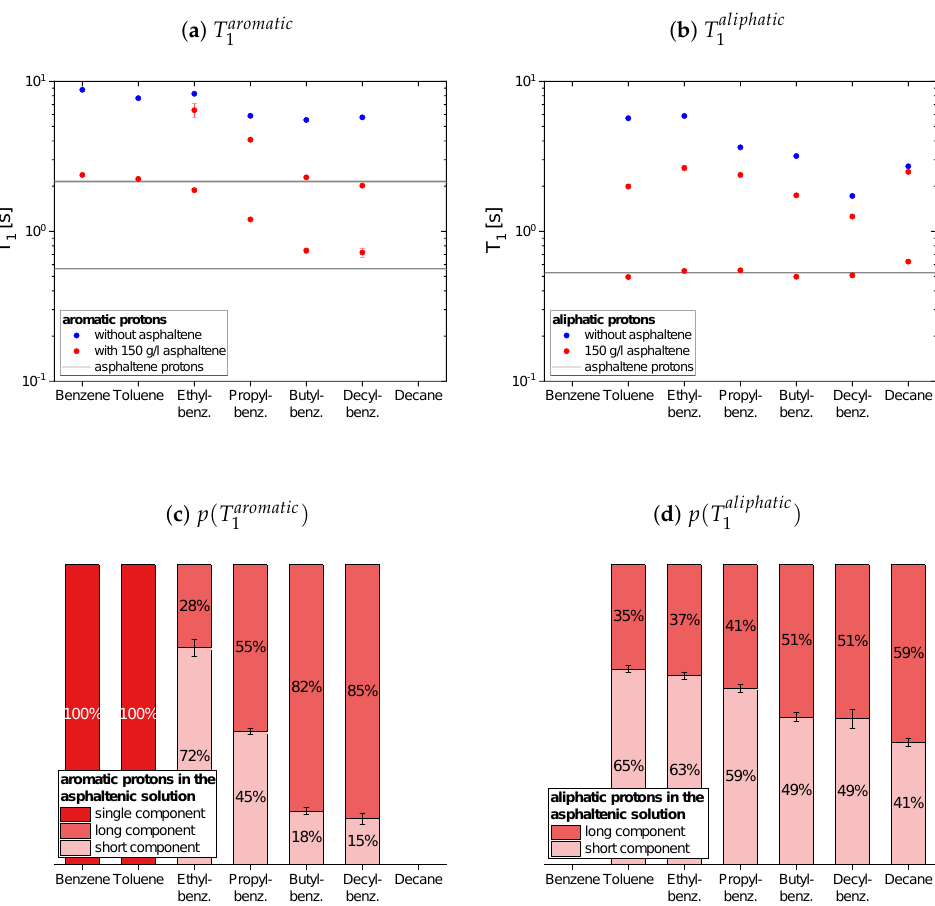
Figure 7. Top: Longitudinal relaxation time constants T 1 of the aromatic ( a ) and aliphatic ( b ) protons in the asphaltene-free and the asphaltenic solution. The black lines indicate the T 1 constants of the asphaltene protons in a benzene-d 6 solution. Bottom: Relative weight of the T 1 components of the aromatic ( c ) and aliphatic ( d ) protons in the asphaltenic solution. The x-axis distinguishes the different solutions, consisting of 5vol% of the specified maltene and 95vol% benzene-d 6 without or with 150g/L